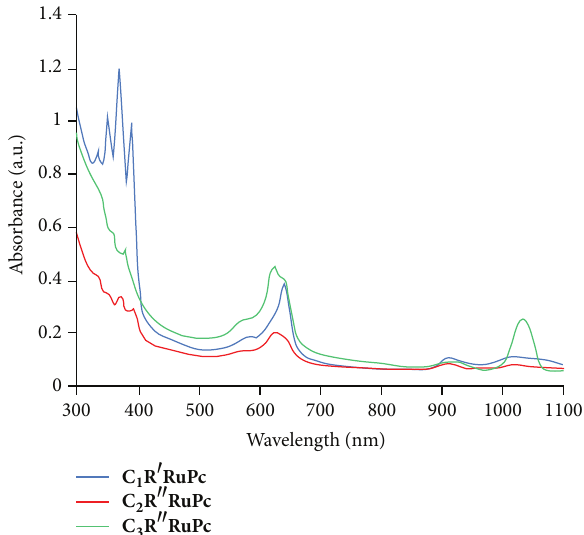
Figure 3: 1 H NMR spectrum of C 1 R 󸀠 RuPc . FH-RuPc R- 2 100 , DMSO, zg 30 :